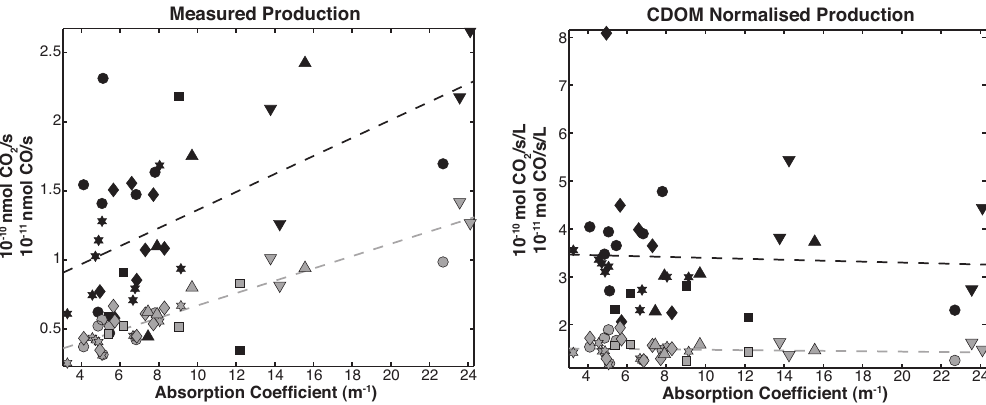
Fig. 5. Measured production and CDOM normalized production with respect to absorption coefficient of sample at 320nm. Black symbols represent CO 2 ( R 2 = 0 . 32 measured, 0.002 normalized) and grey symbols represent CO ( R 2 = 0 . 86 measured, 0.01 normalized).